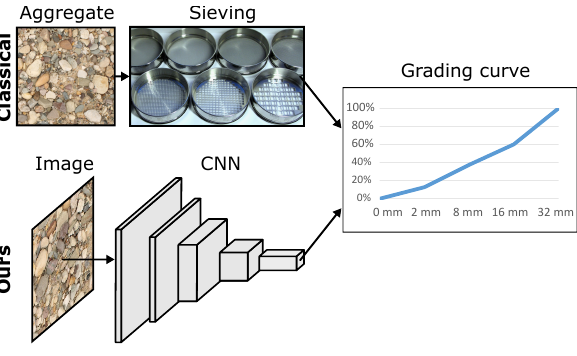
Figure 1. Traditional estimation of the grading curve using mechanical sieving (top row) vs. image and deep learning based prediction of grading curves as proposed here (bottom